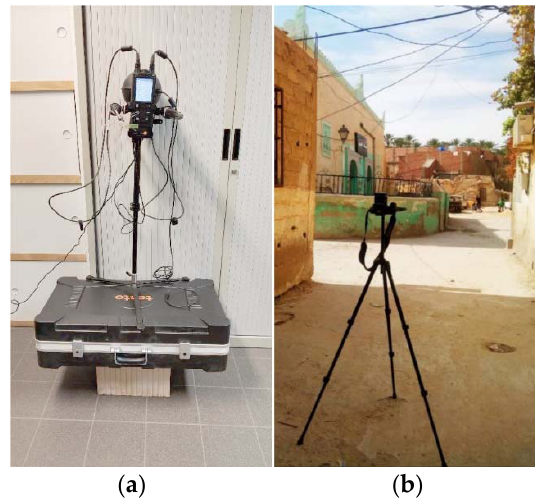
Figure 4. Instruments used for the study fields: ( a ) meteorological station, ( b ) fish ‐ eye camera.